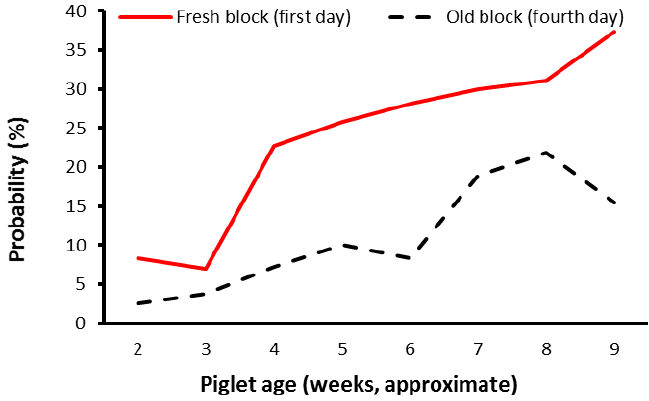
Figure 3. Likelihood that any pig(s) was/were performing oro-nasal contact with the blocks when observed, on the first compared to fourth day that blocks were available within weeks. The values shown are back-transformed means expressed as proportions. Pigs were weaned at about age 28 days.